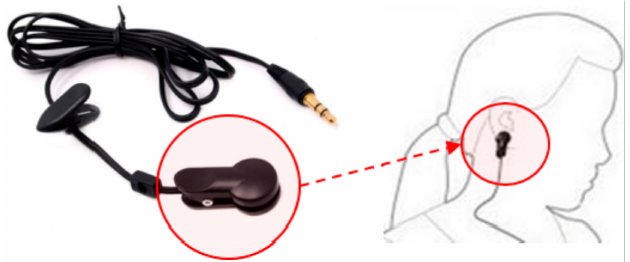
Figure 1. Ear-clip heart-rate